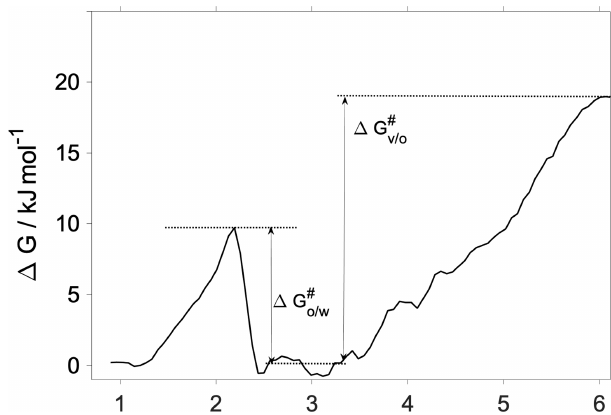
Figure 4. Definition of activation free energies at the different in- terfaces at T =